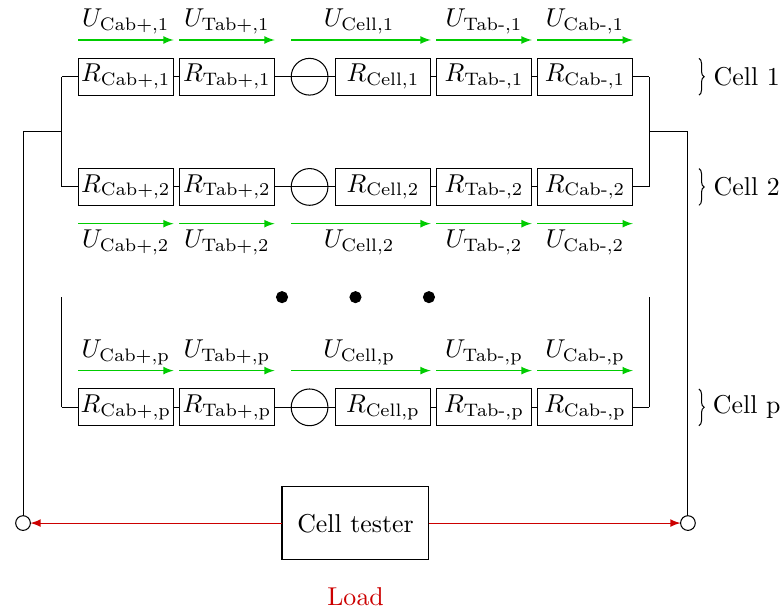
Figure 4. Possible induced resistances by the test bench influencing the current distribution of p parallel-connected cells, with the contact resistances at the positive R Tab+ and negative tab R Tab − , the positive R Cab+ and negative cable resistances R Cab- as well as the cell resistance R Cell